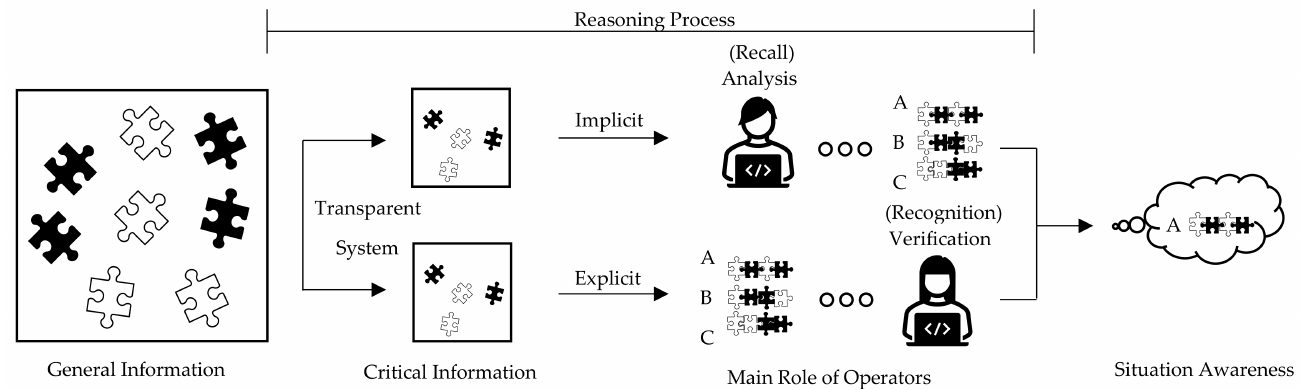
Figure 3. The main role of remote operators according to information presentation